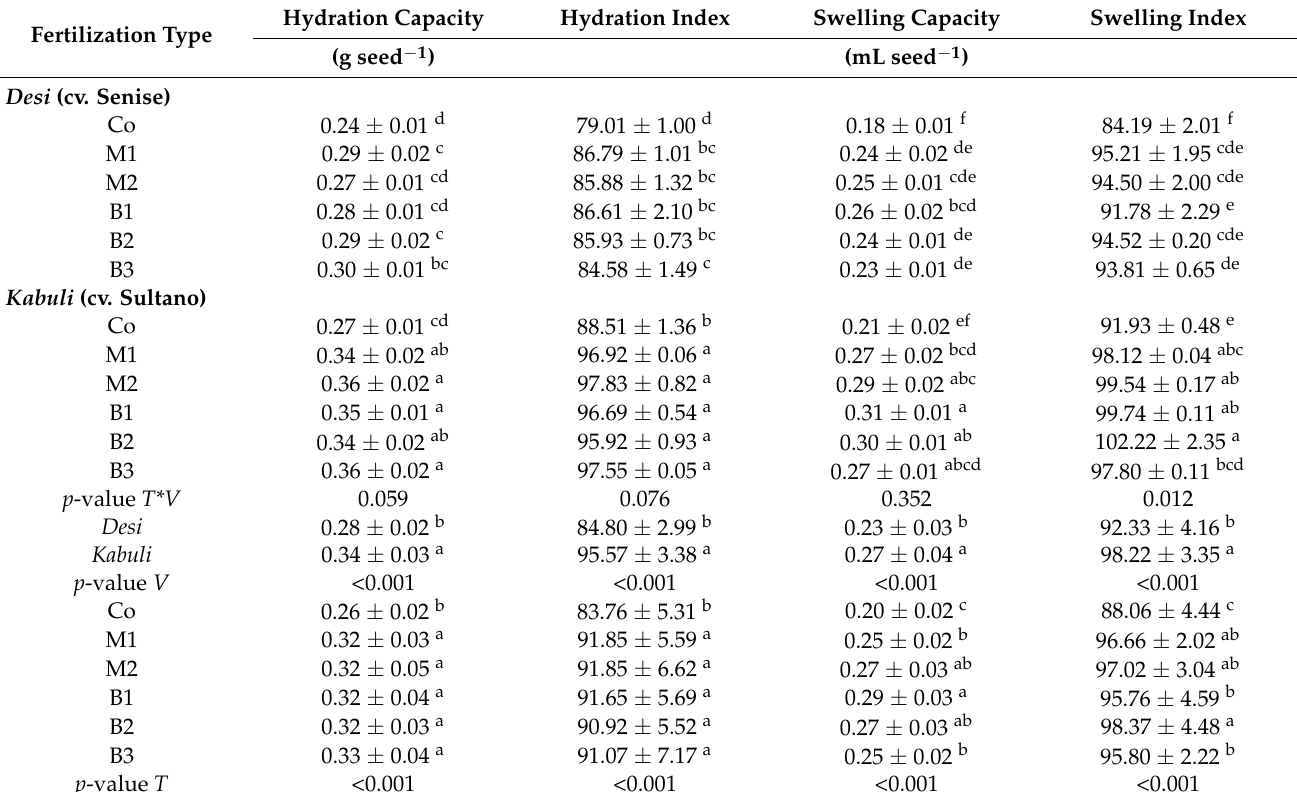
Table 3. The effect of different doses of mineral and organic fertilization on the hydration and swelling properties of desi (cv. Senise) and kabuli (cv. Sultano) chickpeas (mean ± standard